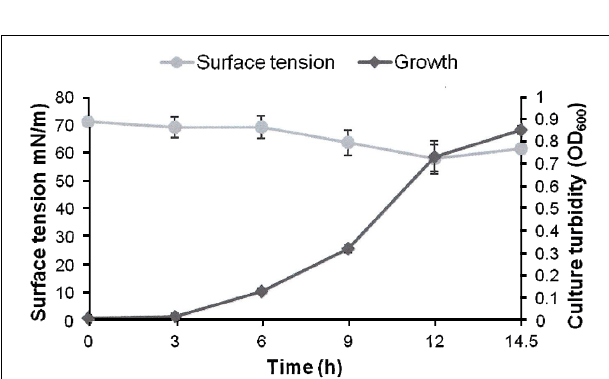
FIGURE 5 | HPLC analysis showing the utilization of DBT-sulfone by AK6U grown in sulfur-free minimal medium containing DBT-sulfone as a sole sulfur source and glucose as a carbon source. The chemical structure of DBT-sulfone is shown and refers to the major peak in the chromatogram (retention time 3.7